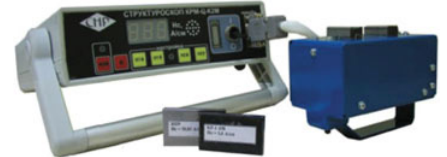
Fig. 1. The device for coersive force